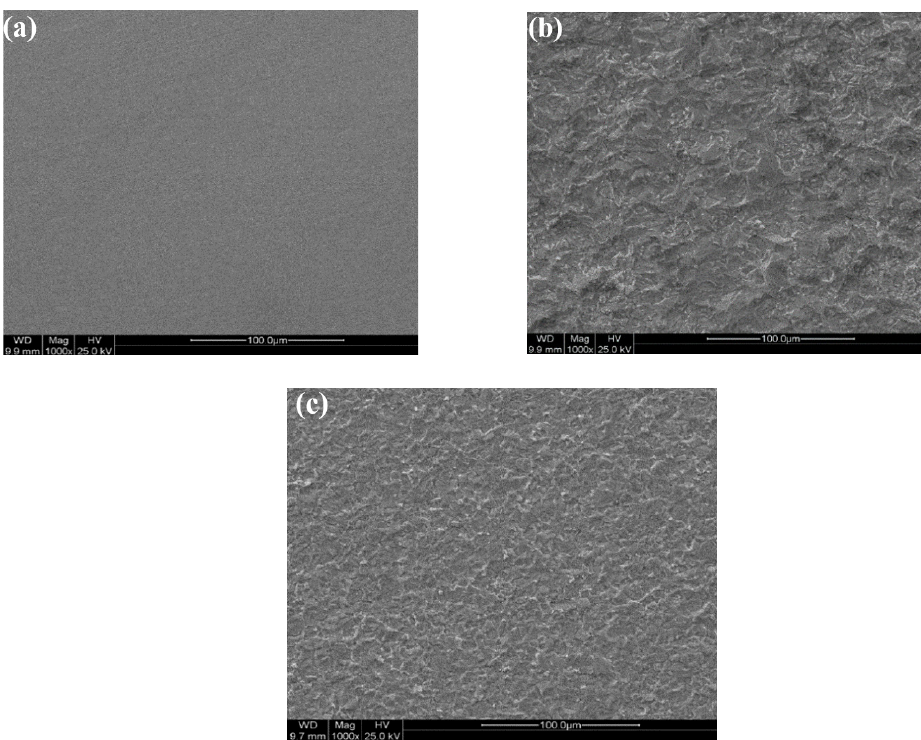
Figure 10. SEM micrographs of ( a ) a polished C-steel coupon in the ( b ) absence and ( c ) presence of 2.22 mmol·L −1 Q-22